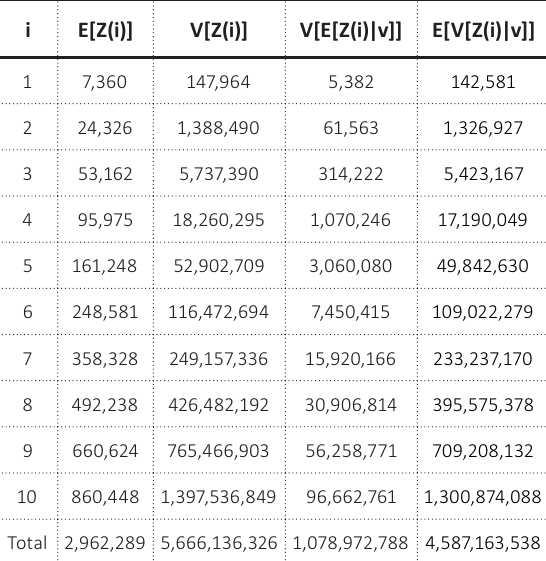
Table 1. Base scenario: hypothesis 2